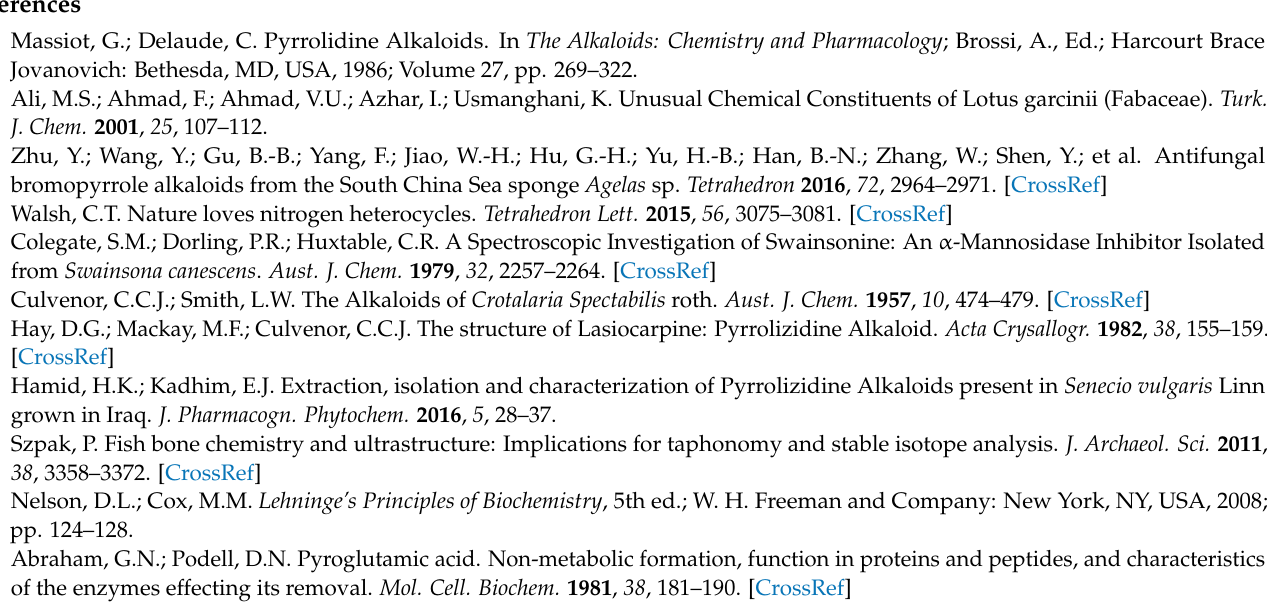
the way for new enantiomerically pure functionalized phosphonate analogues of prolines, substituted glutamic acid by application of the N -chiral C -phosphorylated nitrones. Supplementary Materials: Figure S1: 1 H NMR Spectrum for 20 in CDCl 3 , Figure S2: 13 C NMR Spectrum for 20 in CDCl 3 , Figure S3: 31 P NMR Spectrum for 20 in CDCl 3 , Figure S4: 1 H NMR Spectrum for 21 in CDCl 3 , Figure S5: 1 H NMR Spectrum for 21 in C 6 D 6 , Figure S6: 13 C NMR Spectrum for 21 in C 6 D 6 , Figure S7: 31 P NMR Spectrum for 21 in CDCl 3 , Figure S8: 31 P NMR Spectrum for 21 in C 6 D 6 , Figure S9: 1 H NMR Spectrum for 23 in CDCl 3 , Figure S10: 13 C NMR Spectrum for 23 in CDCl 3 , Figure S11: 31 P NMR Spectrum for 23 in CDCl 3 , Figure S12: 1 H NMR Spectrum for 18 in CDCl 3 , Figure S13: 13 C NMR Spectrum for 18 in CDCl 3 , Figure S14: 31 P NMR Spectrum for 18 in CDCl 3 , Figure S15: 1 H NMR Spectrum for 24 in CD 3 OD, Figure S16: 13 C NMR Spectrum for 24 in CD 3 OD, Figure S17: 31 P NMR Spectrum for 24 in CD 3 OD, Figure S18: 1 H NMR Spectrum for 25 in CDCl 3 , Figure S19: 13 C NMR Spectrum for 25 in CDCl 3 , Figure S20: 31 P NMR Spectrum for 25 in CDCl 3 , Figure S21: 1 H NMR Spectrum for 27 in CDCl 3 , Figure S22: 1 H NMR Spectrum for 27 in CD 3 OD, Figure S23: 13 C NMR Spectrum for 27 in CD 3 OD, Figure S24: 31 P NMR Spectrum for 27 in CDCl 3 , Figure S25: 1 H NMR Spectrum for 28 in CDCl 3 , Figure S26: 13 C NMR Spectrum for 28 in CDCl 3 , Figure S27: 31 P NMR Spectrum for 28 in CDCl 3 , Figure S28: 1 H NMR Spectrum for 29 in CDCl 3 , Figure S29: 13 C NMR Spectrum for 29 in CDCl 3 , Figure S30: 31 P NMR Spectrum for 29 in CDCl 3 , Figure S31: 1 H NMR Spectrum for 30 in CDCl 3 , Figure S32: 1 H NMR Spectrum for 30 in CDCl 3 , Figure S33: 31 P NMR Spectrum for 30 in CDCl 3